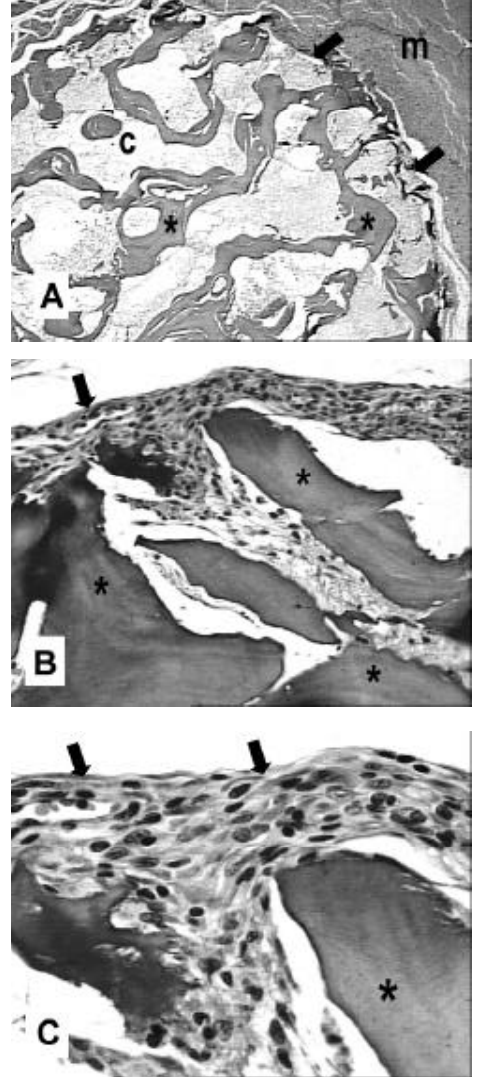
FIGURA 2 - Fotomicrografia do período de 7 dias: A) Vista geral do material implantado (*) entre os feixes musculares (m), presença de coágulo (c) e formação de cápsula (setas largas), HE, 38x; B) e C) Migração (setas largas) do tecido conjuntivo entre dos espaços ósseos, HE,